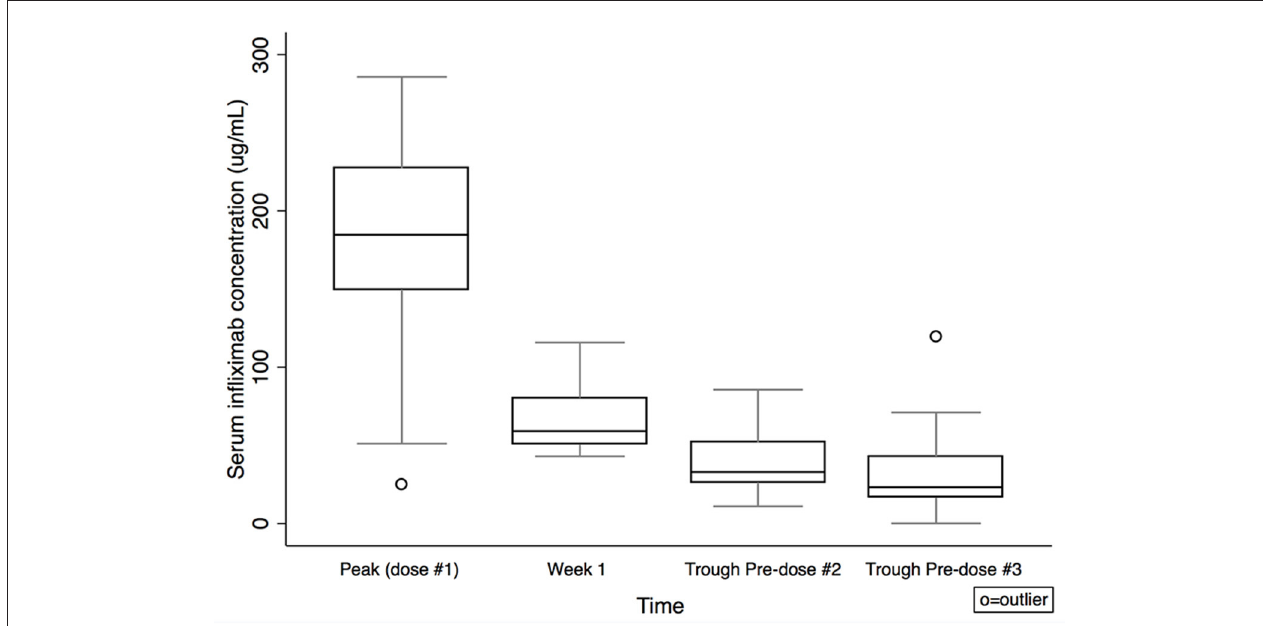
FIGURE 1 | Serum infliximab concentrations by time. Box plot values include: lower adjacent value, first quartile, median, third quartile, and upper adjacent value (in ascending order). Lower and upper adjacent values are the most extreme values within the first quartile minus 1.5 × interquartile range and the third quartile plus 1.5 × interquartile range, respectively.